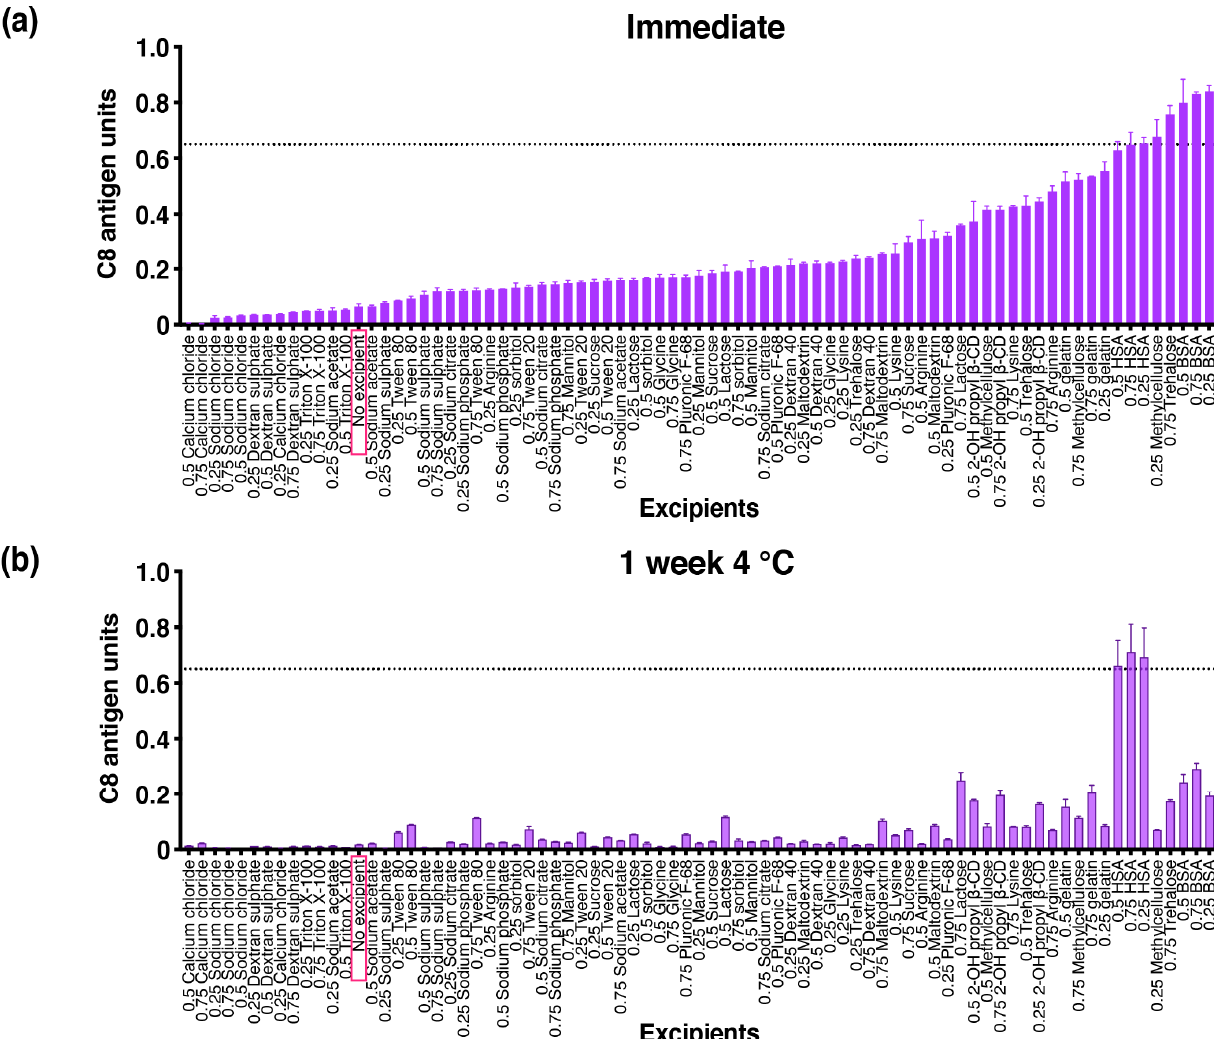
Figure 1. Effects of individual excipients on bDENV2 antigen recovery ( a ) upon immediate reconstitution after drying and ( b ) after storage for 7 days at 4 °C. Each condition is shown as a relative percentage recovery of bDENV2 antigen normalized to a bDENV2 stock liquid control (100%). Note: Excipients were prepared in a low-salt base buffer. Error bars represent SEM from triplicate experiments. The dotted line across the graph represents 65% recovery of bDENV2.